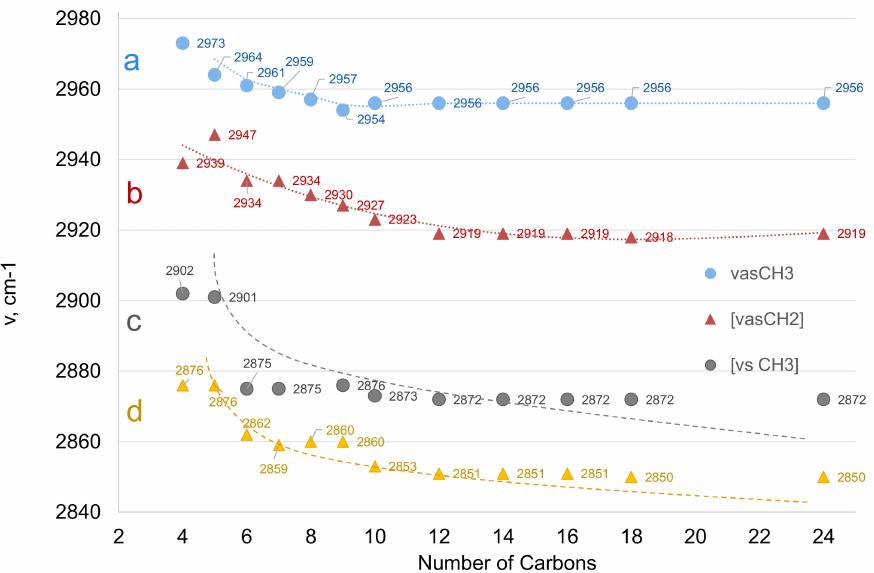
Figure 3. Graph illustrating the trends for (a) v as CH 3 , (b) v as CH 2 , (c) v s CH 3 , and (d) v s CH 2 peak maxima with respect to the total number of carbons in sFA. Lower-chain acids, not discussed in the main text, are included to further emphasize the